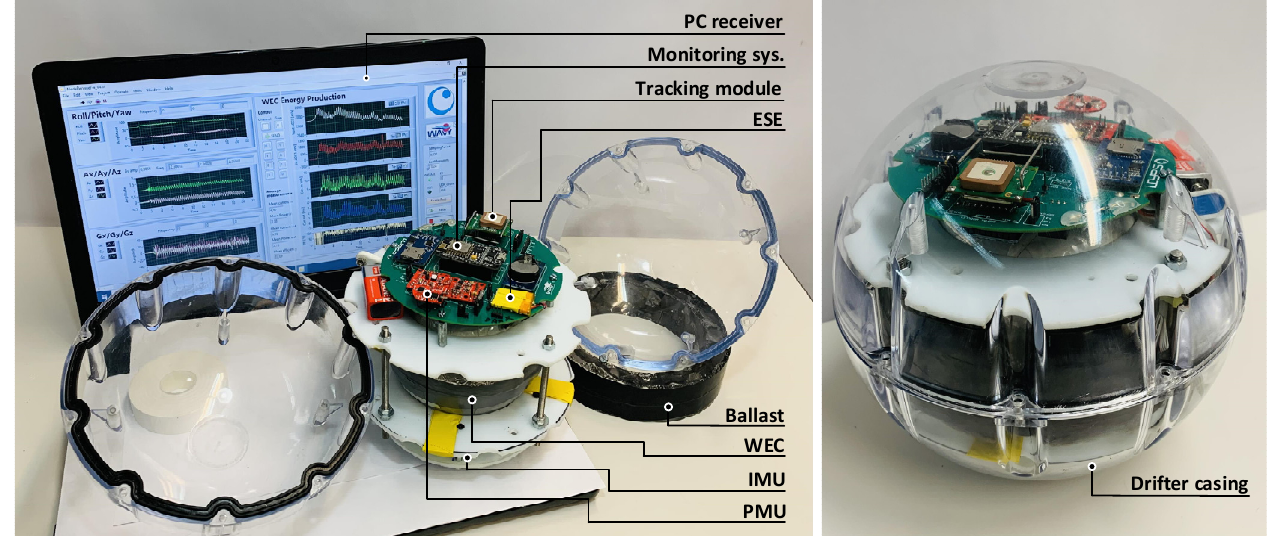
Figure 7. Experimental set-up for the tests. Left : the EH and monitoring systems with the two semi-spheres of the drifter, the ballast and the PC receiver. Right : spherical drifter casing with the EH and monitoring systems embedded.